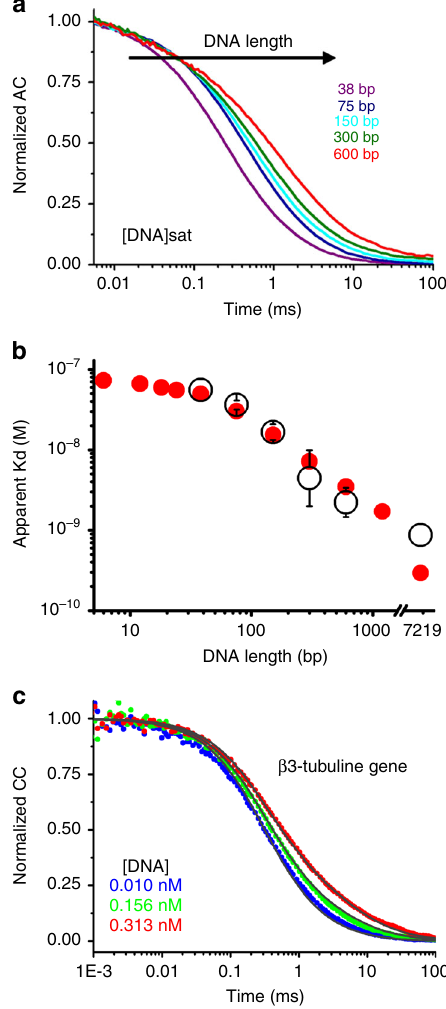
Fig. 5 Ampli fi cation of EngHD binding af fi nity induced by the fl anking region. a FCS autocorrelation decays of EngHD measured in the presence of saturating concentrations of DNA molecules of different size. b Dissociation constants of EngHD binding to DNA molecules of varying size determined experimentally by FCS from three independent experiments on the 5 DNAs of panel a (open black circles), and predicted by the model (red circles). The data at 7219 bp corresponds to the af fi nity of the β 3-tubulin gene (panel c ) with experiment and model prediction as before. c FCS cross-correlation decays of EngHD measured in the presence of various concentrations of a DNA molecule encompassing the entire β 3-tubulin gene sequence (see Fig. 6b). Bars delimit the 95% con fi dence interval. Source data are provided as a Source Data fi